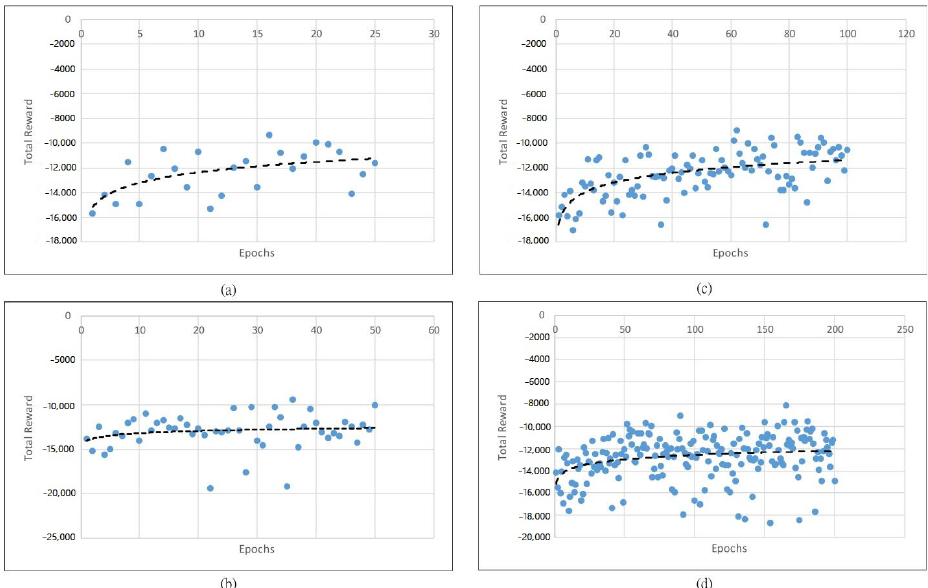
Figure 9. Total reward while training using action time step 0.5 s with epochs ( a ) 25, ( b ) 50, ( c ) 100, and ( d )